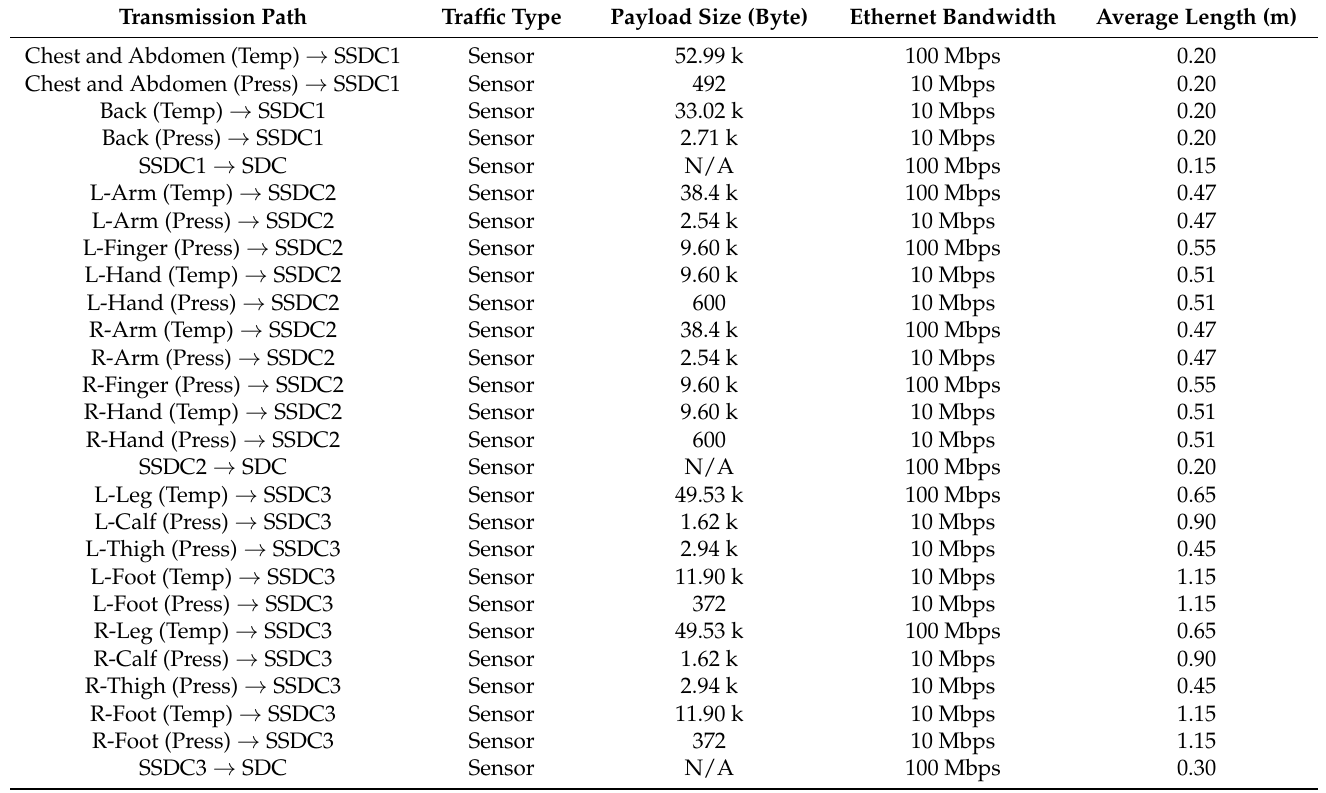
Table 2. Data transmission link parameters of the DIRA Skin Domain.